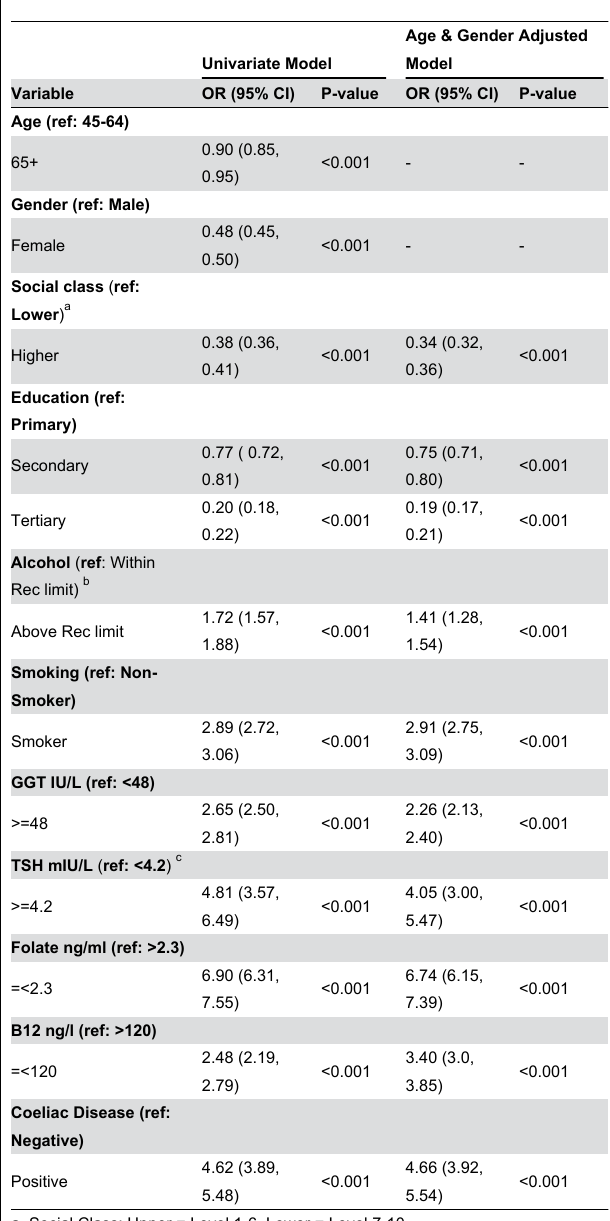
Table 4. Univariate and Multivariate Associations with Macrocytosis > 99